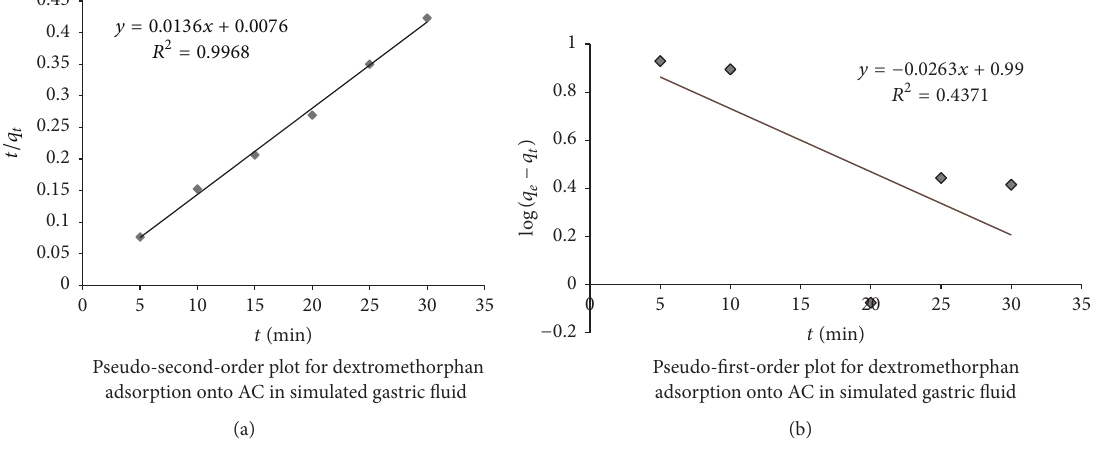
Figure 4: (a) Pseudo-second-order plot for adsorption of DXM on AC in SGF and (b) pseudo-first-order plot for adsorption of DXM on AC in SGF.